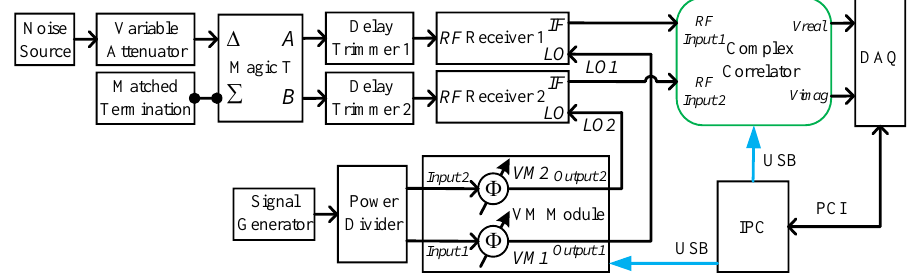
Figure 3. The correlator’s outputs DC offsets and quadrature errors calibration measurement test bench. The two receivers and the complex correlator in Figure 3 can be regarded as a single baseline interferometer; for an interferometer baseline which uses a complex correlator with a rectangular